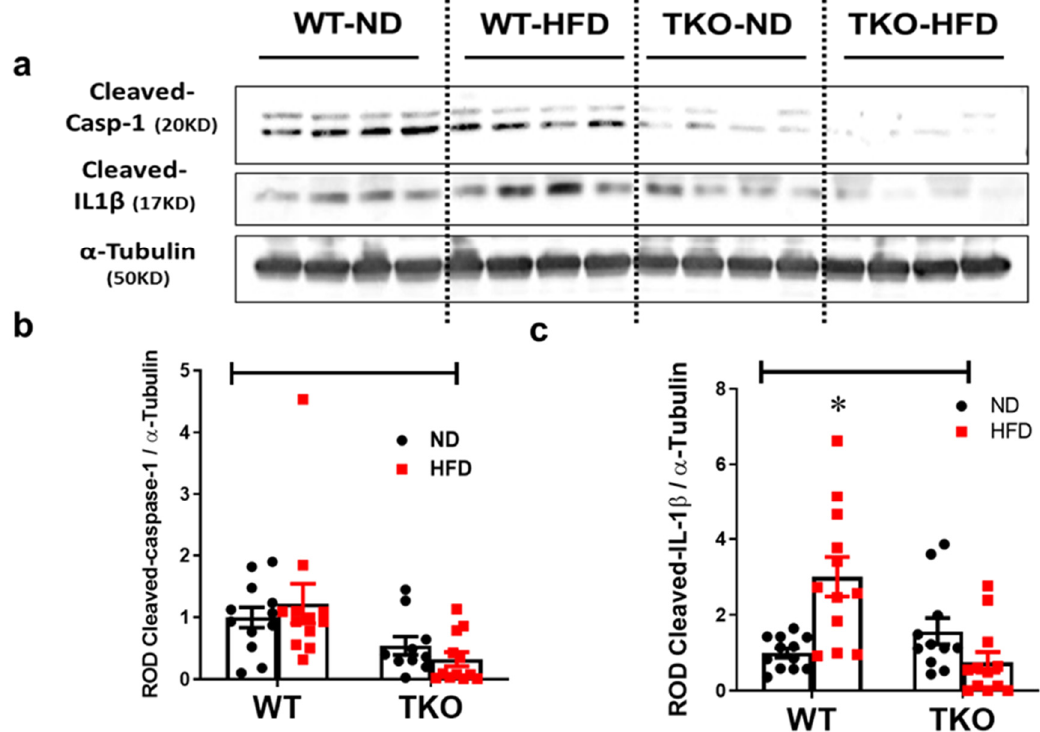
Figure 4. Deletion of TXNIP abrogates HFD-induced NLRP3-inflammasome activation in the retina. Representative WB blots ( a ) and statistical analyses of protein expression of retinal ( b ) cleaved caspase-1 and ( c ) cleaved IL-1 β showed a significant increase in cleaved IL-1 β expression, and a trend towards higher levels of cleaved caspase-1 in WT-HFD group compared with WT-ND. In contrast, TKO-ND and TKO-HFD groups showed either no changes or significantly lower levels of all target protein expression compared with WT-ND group, respectively. Two-way ANOVA showed significant interaction between the type of diet across cleaved IL-1 β expression and between the genotype across expression of cleaved IL-1 β and cleaved caspase-1 ( n = 12 mice / group; * p < 0.05 vs. other groups).